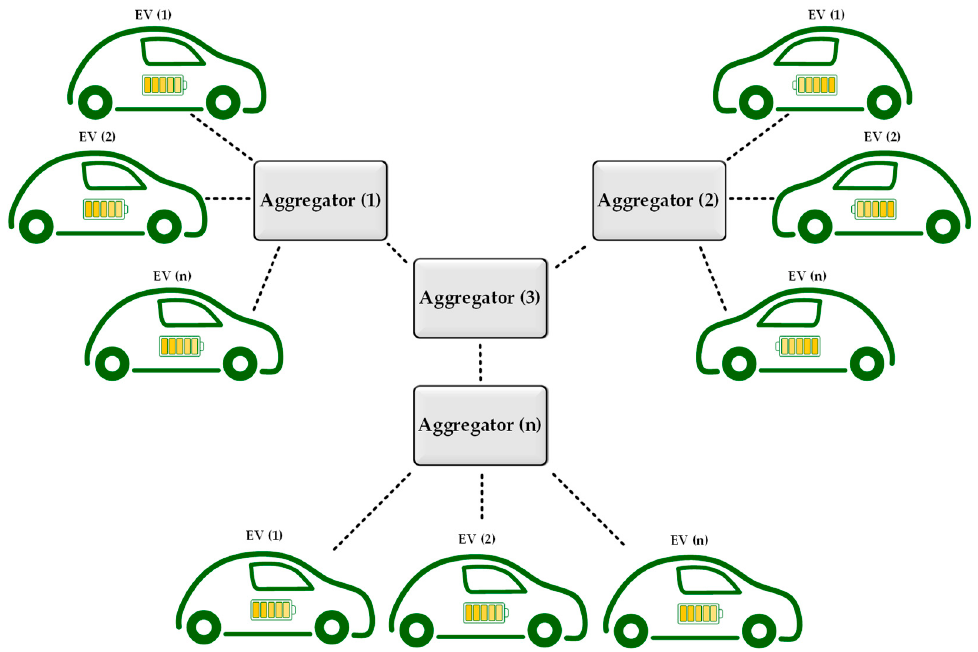
Figure 10 . Hierarchical control architecture of EV charging [13,69]. Figure 10. Hierarchical control architecture of EV charging